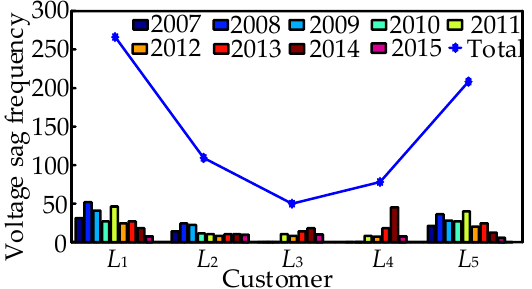
Figure 9. Voltage sag frequency statistics for L 1 ~ L 5 .